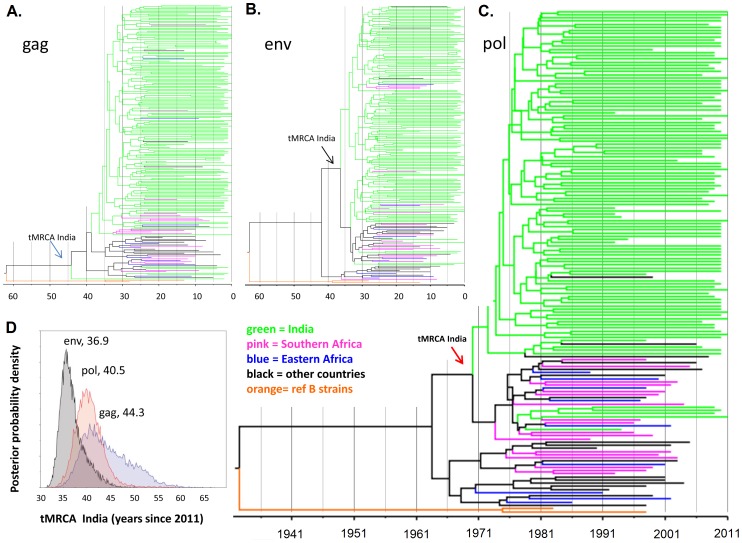
Annotated phylogenetic trees for the gag- (Panel A), env (Panel B) and pol- (Panel C) genes.Phylogenetic trees were constructed using the Indian HIV-1 subtype C from clinical samples taken from different parts of India (shown in green), including southern (Karnataka, Tamil Nadu and Andhra Pradesh), northern (Punjab and Haryana), north-eastern (Manipur) and central (Madhya Pradesh) regions of India plus data base retrieved reference sequences from western India and other countries, and two out-group subtype B strains. The Indian tMRCA included in this study were shown with an arrow. Pol-gene analysis was considered to provide the most reliable estimate of tMRCA (shown with a red arrow) for Indian HIV-1C, indicating around 1971 (95% CI: 1965–1976)]. Posterior probability plots showing the tMRCA estimates of Indian HIV-1C (Panel D): The posterior probability density plots for the three genes (env, pol and gag) point to a tMRCA for Indian HIV-1C from 36.9 (env), 40.5 (pol) and 44.3 (gag) years ago, with an overall mean for the combined graph at 40.6 years ago before 2011, that is in 1970.4 (95% CI: 1960.3–1978.1).